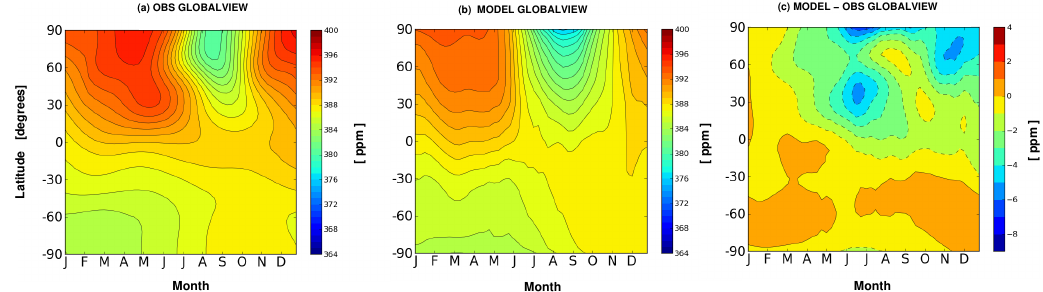
Figure 3. NOAA GLOBALVIEW CO 2 (2011) product for 2010 based on observations (left) compared to the equivalent product based on the atmospheric CO 2 hindcast (middle). The difference between the GLOBALVIEW product based on observations and model is shown in the right panel. The CO 2 hindcast has been sampled at the same locations as the GLOBALVIEW observations and the same data processing described in Masarie and Tans (1995) has been